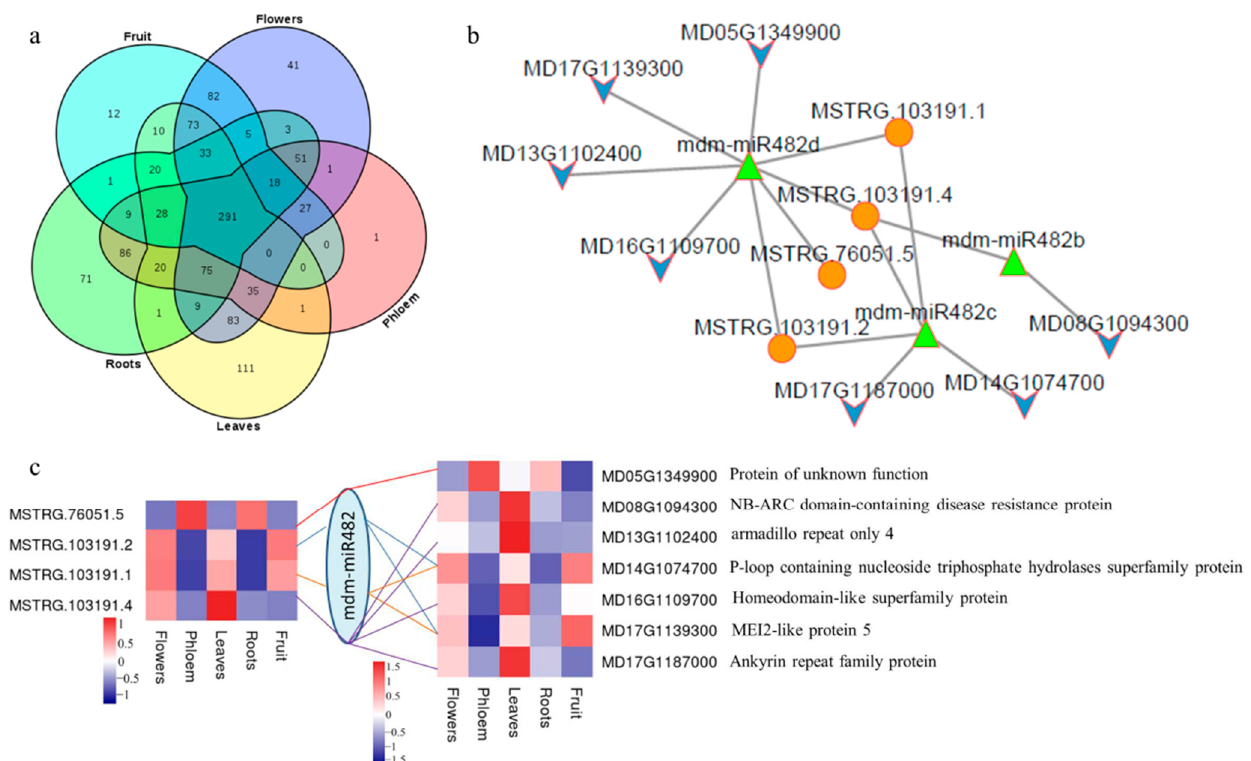
Figure 5. Tissue-specific characteristics and functions, and prediction of lncRNA-miRNA-mRNA. ( a ) Venn diagram of interactions between lncRNAs and miRNAs of five tissues. ( b ) lncRNA-miRNA-mRNA networks for mdm-miR482 (orange circle: lncRNAs; green triangle: mdm-miRNAs; blue arrow: mRNAs). ( c ) Pearson correlation coefficient for expression of lncRNAs and mdm-miR482 in five tissues and functions of